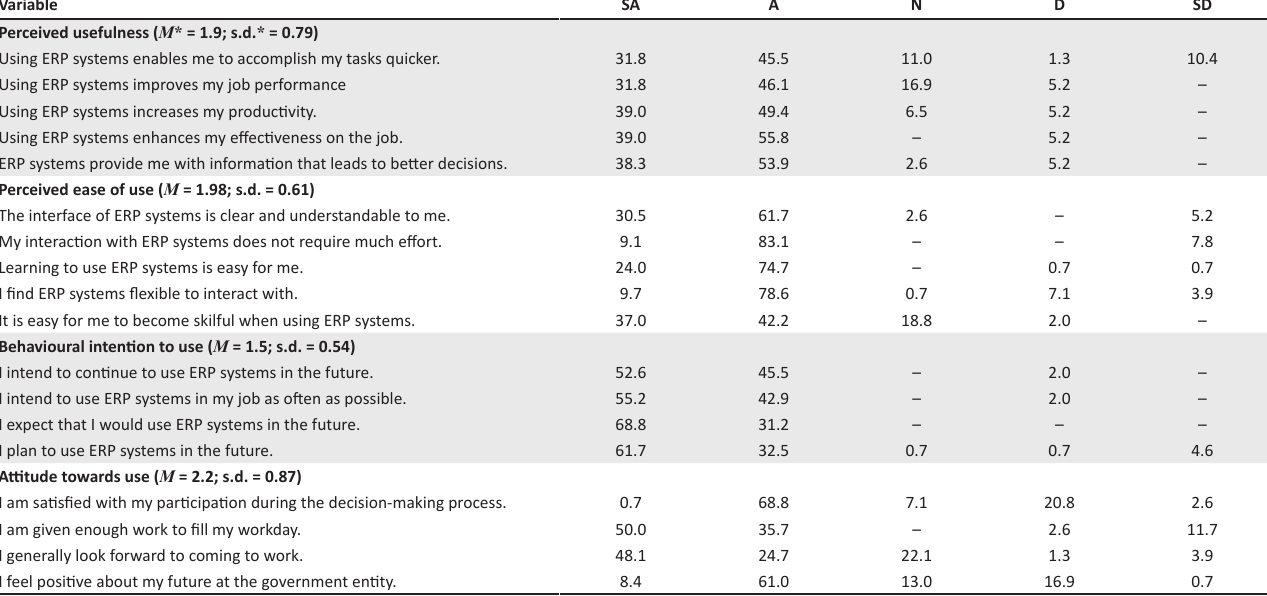
TABLE 1: Descriptive statistics – Attitude, intention and usage factors. Variable SA